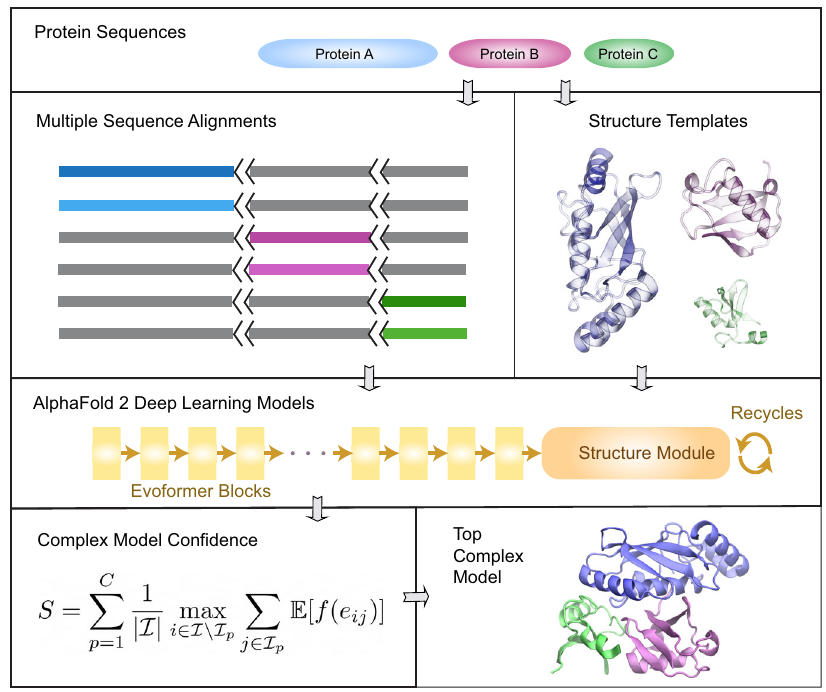
Fig. 1 Overview of the AF2Complex work fl ow. The multiple sequence alignments of query protein sequences A (blue), B (purple), and C (green) are joined together by padding gaps (grey) in the MSA regions belonging to other proteins, and the short black lines represent an increase in the residue index to distinguish separate protein chains. Structure templates for individual proteins are also retrieved from the Protein Data Bank. Using these sequence and template features, an AF2 DL model generates a complex model after multiple recycles. The interface residues between proteins in the fi nal complex model are then identi fi ed and their interface-score S is calculated to rank model con fi